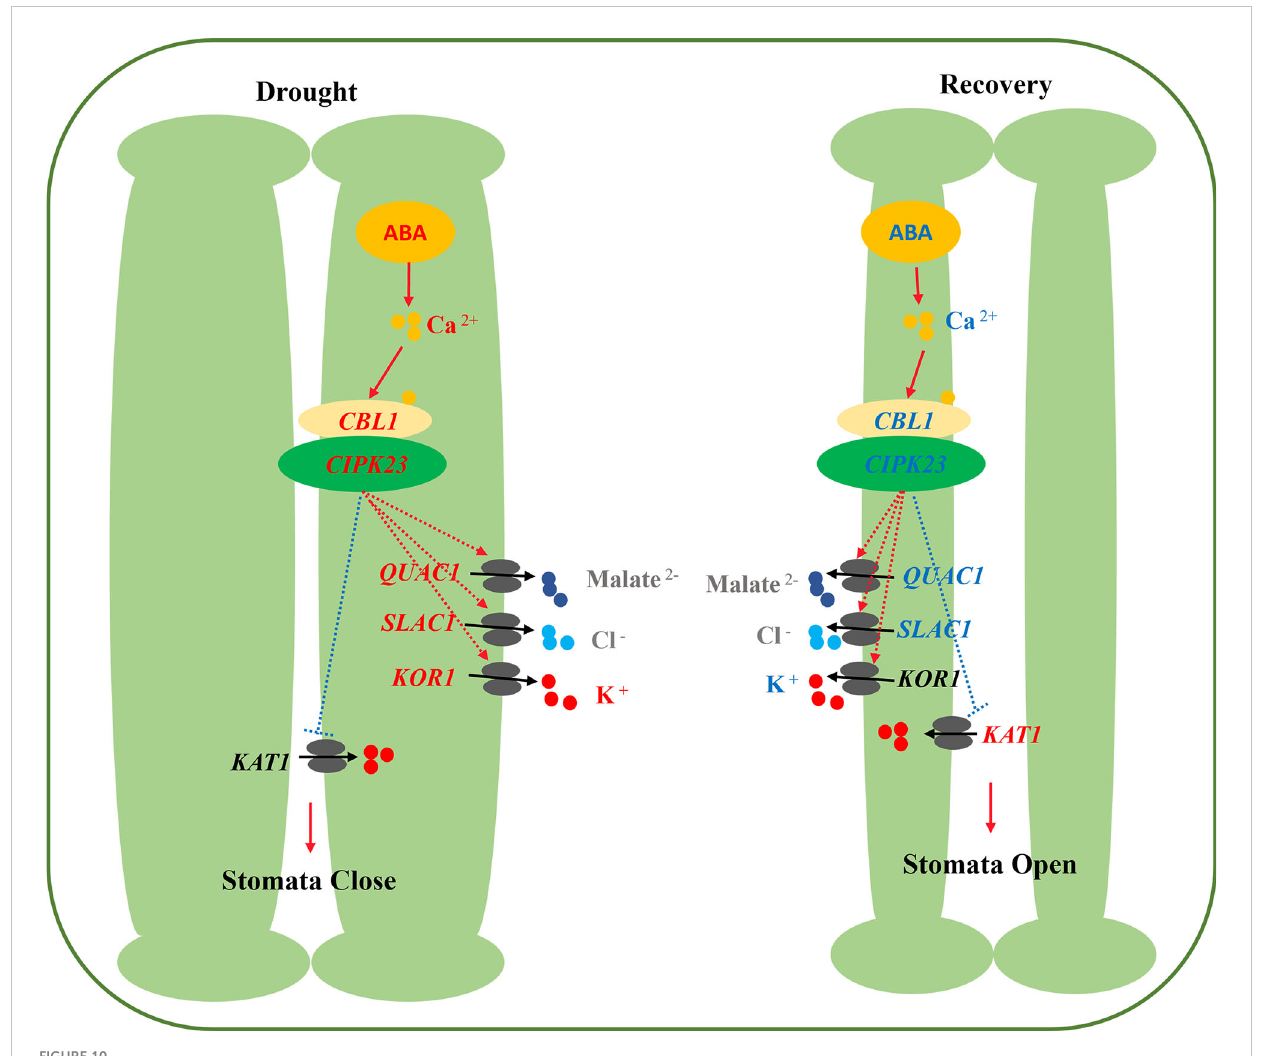
FIGURE 10 Physiological mechanisms of stomatal movement induced by drought priming. Red indicate the higher expression and blue indicate the lower expression in PD than in